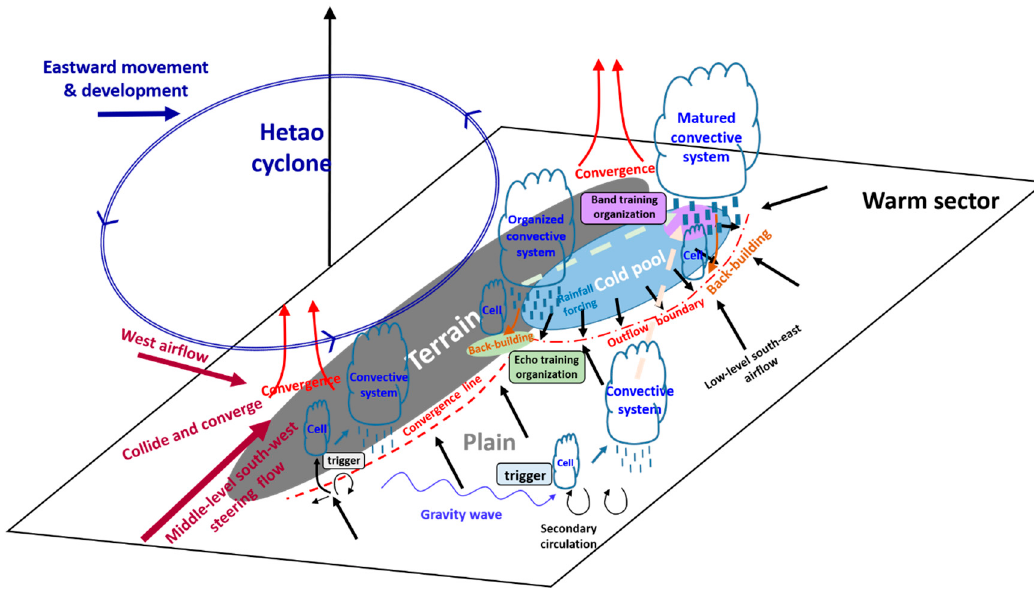
Figure 18. Conceptual model of the probable initiation and organization mechanisms of the mesoscale convective systems in this warm-sector torrential rain event over Beijing.